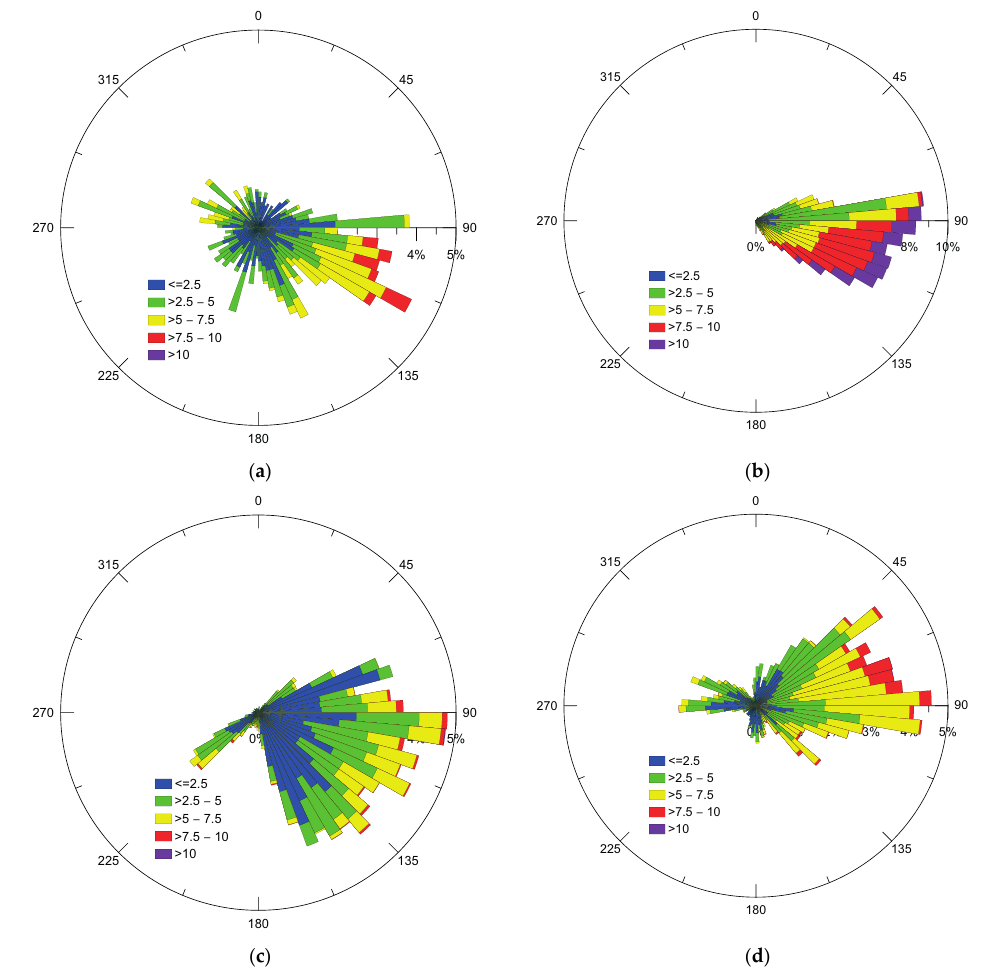
Figure 2. The preliminary wind atlas in the region of measurement at the height of 2 m for the years: ( a ) 2009; ( b ) 2011; ( c ) 2013; ( d ) 2020. The values are given in m s − 1 . The east wind directions are typical for observation period during each field campaigns.